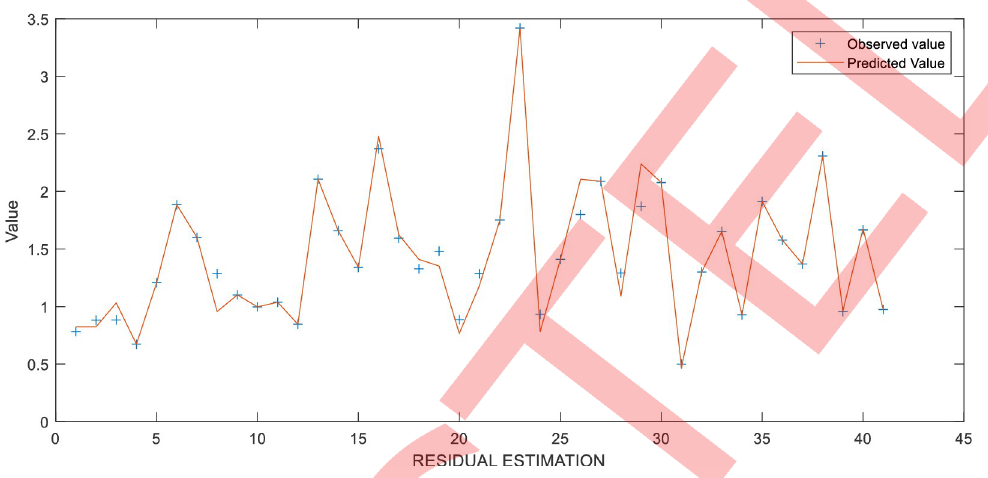
Fig 3. Measurement, estimated values, and residual values.